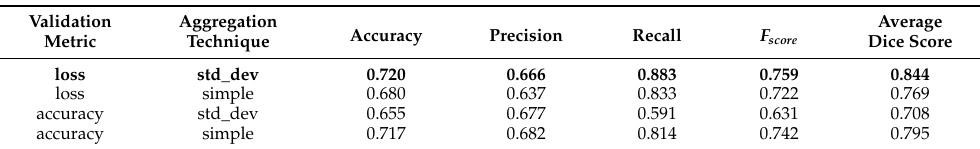
Table 1. Results of server-centric federated semi-supervised learning experiments. The best perfor- mance is highlighted in bold.